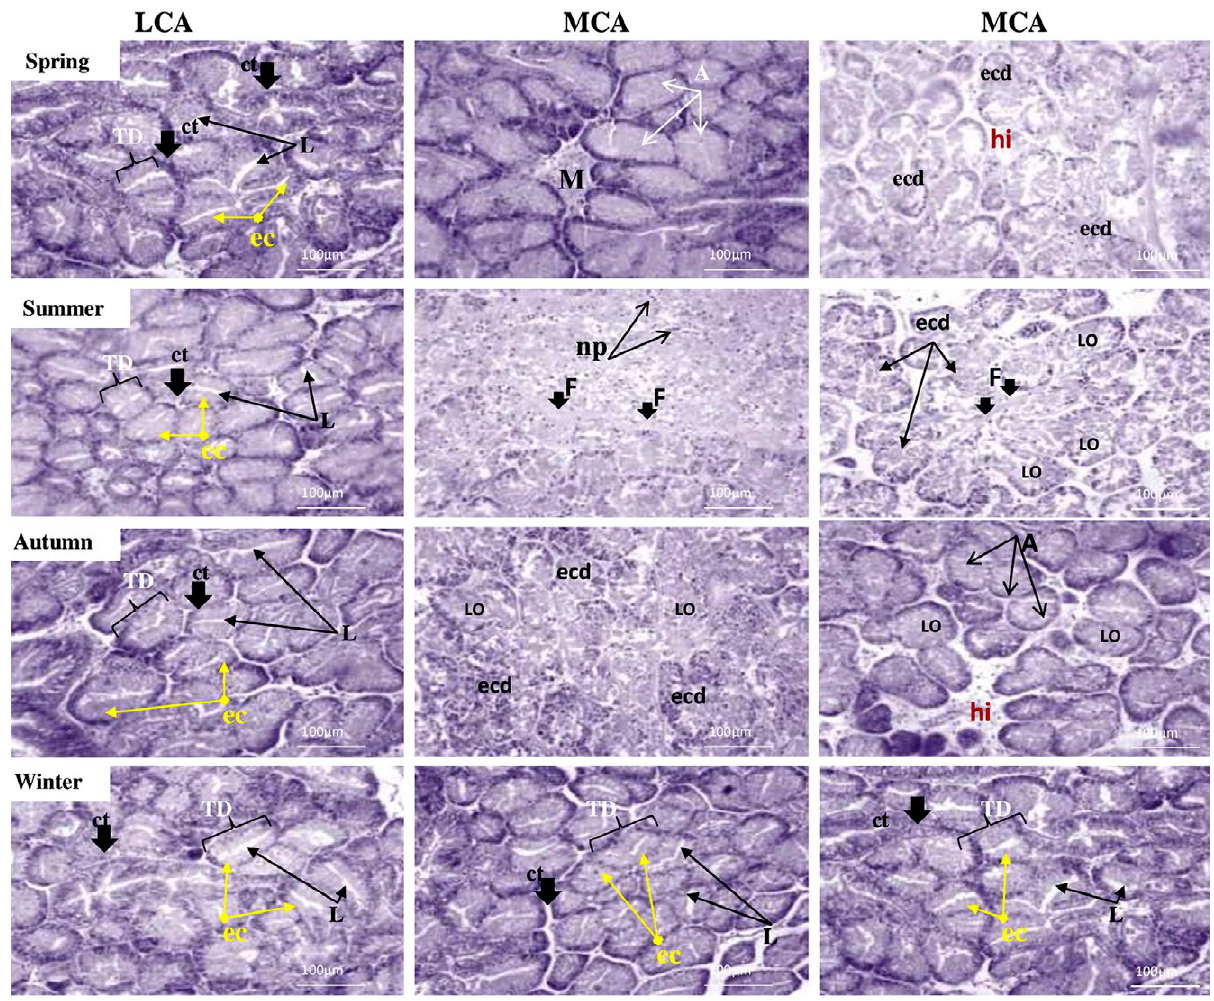
Fig. 6. – Histological sections of R. decussatus digestive glands from three coastal Tunisian lagoons: Ghar el Melh (LCA), the North Lake (MCA) and the South Lake (HCA). A, atrophy; ct, connective tissue; ec, epithelial cells; ecd, epithelial cell degradation; F, fibrosis; hi, hemocyte infiltration; L, lumen; LO, lumen occlusion; M, melanin; np, neoplasic hemocytes; TD, digestive tubules. Optic microscopy: haematoxylin-eosin